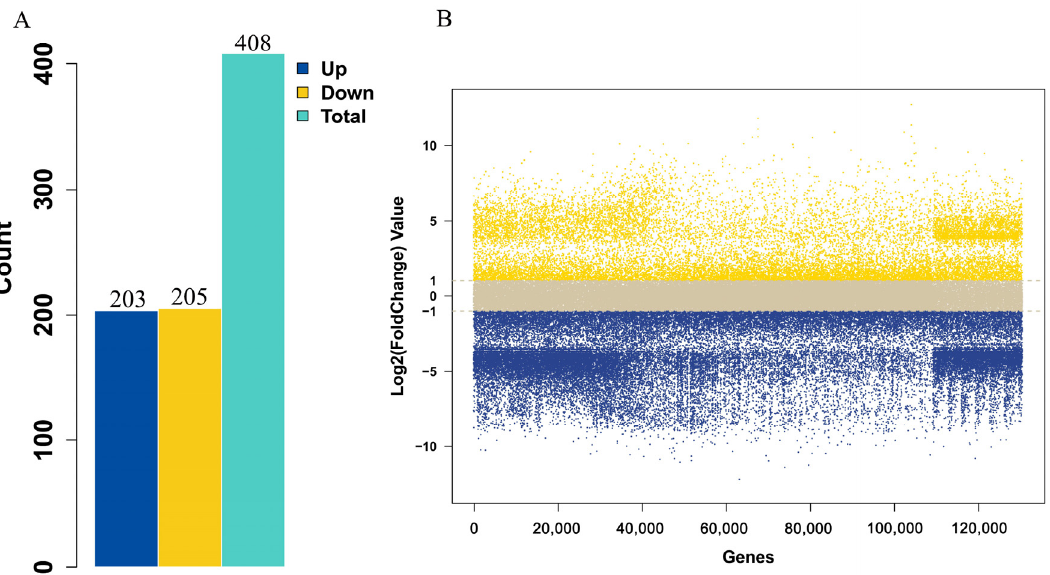
Figure 2. Statistics of the DEGs. ( A ) Number statistics of the DEGs. There were 408 DEGs, of which 203 were significantly up-regulated and 205 were significantly down-regulated in FGW. ( B ) Differential multiple distribution of the DEGs.